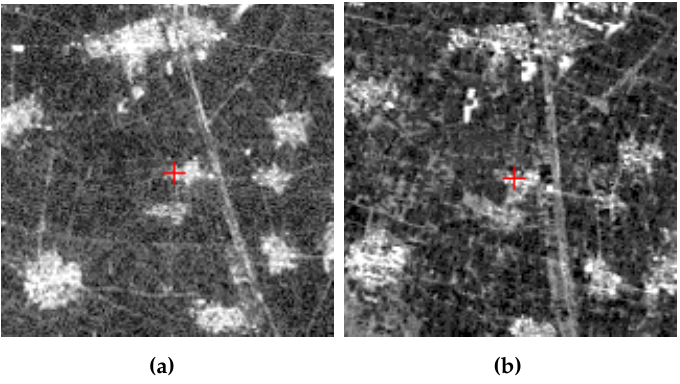
Figure 4. The matched keypoints in a sensed image tile and a reference image tile. ( a ) The sensed image tile; and ( b ) the reference image tile.